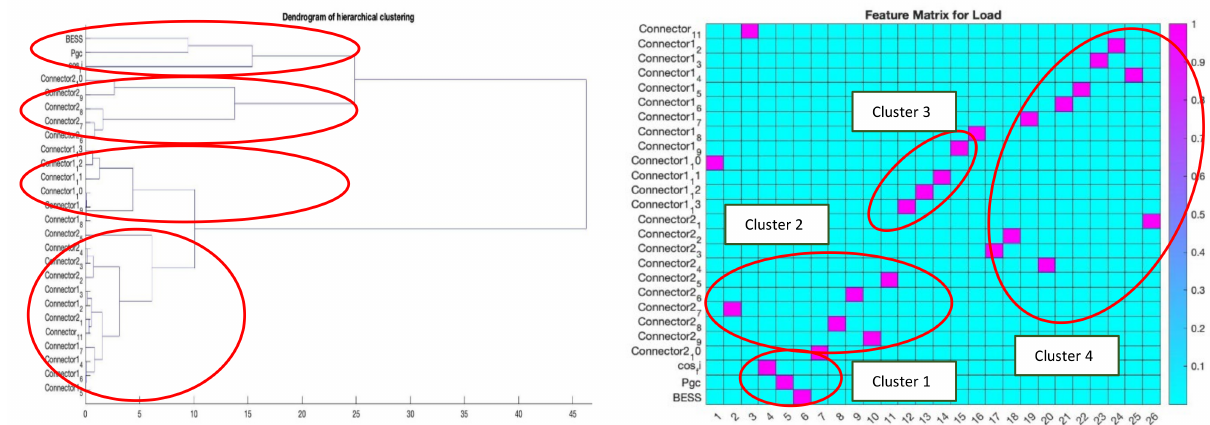
Figure 9. Analysis of the characteristics and their links. Operation system—BESS. The red circles in the figure indicate clusters of data